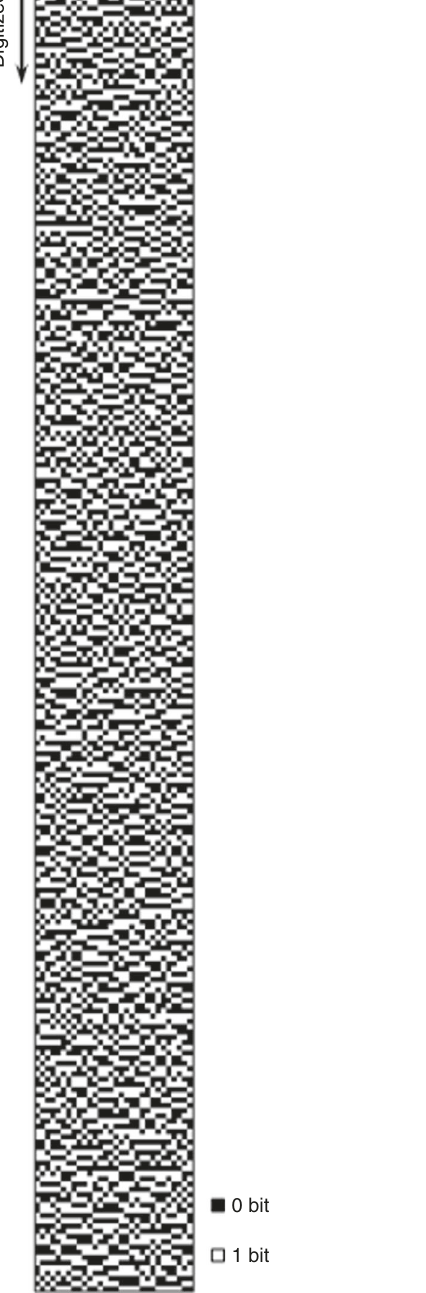
Fig. 5 Representative binary bitmap of cryptographic keys. Digitized security keys (256 bits in each PUF) are generated from 30 different edible PUF devices.